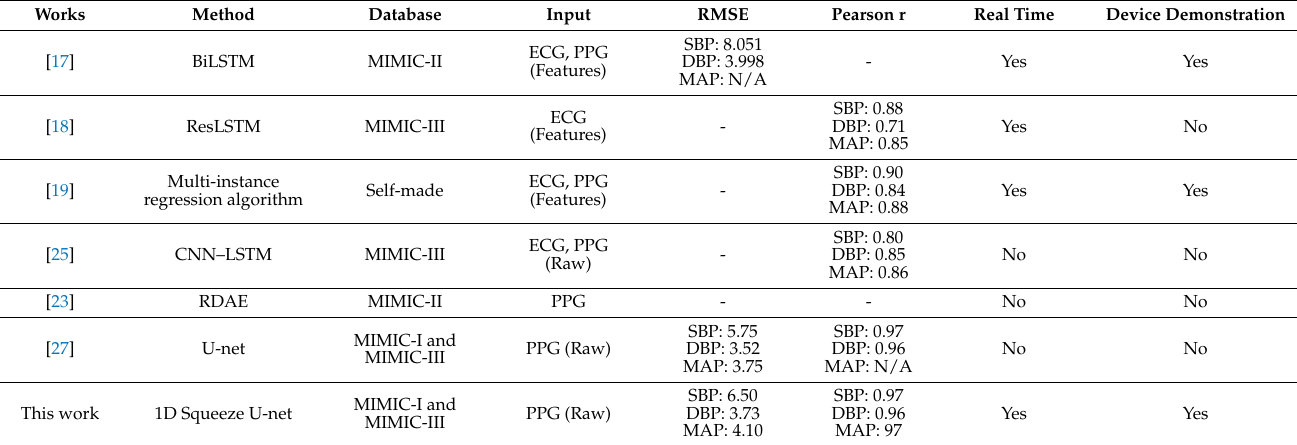
Table 5. Comparison with related works based on real-time BP estimation.